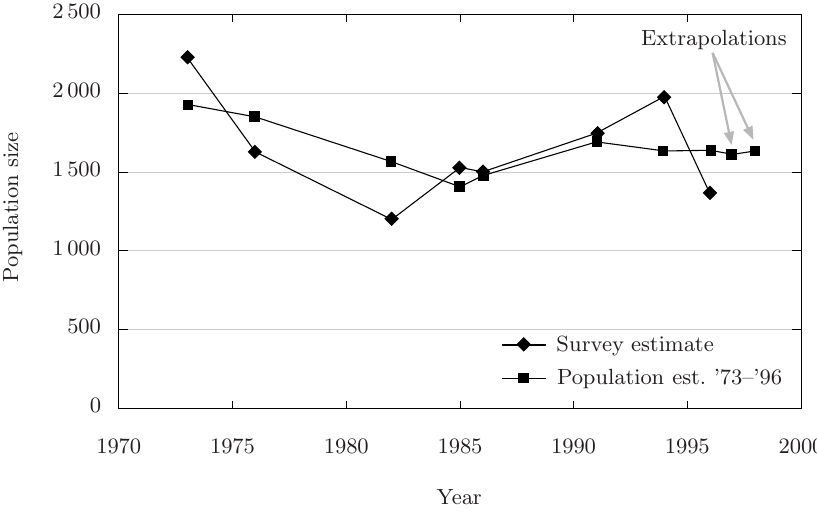
Figure 2: White rhino survey and population estimates from